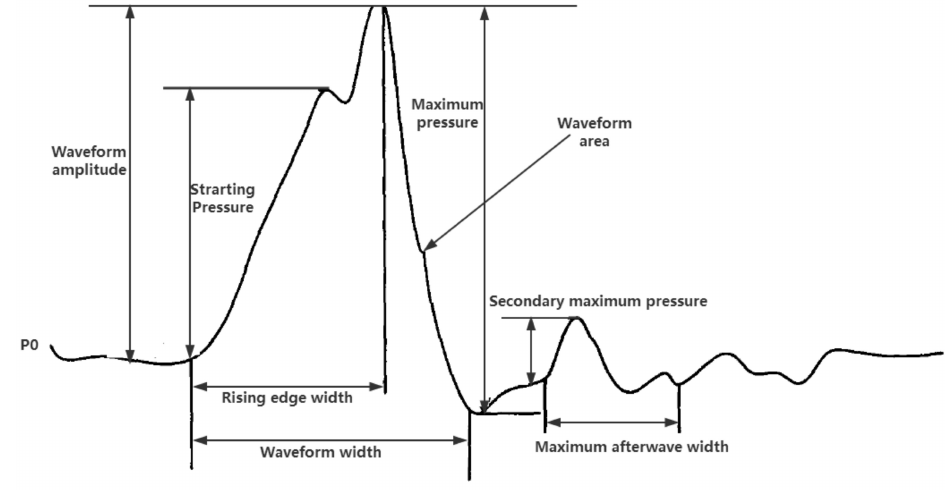
Figure 7. Pressure waveform characteristic